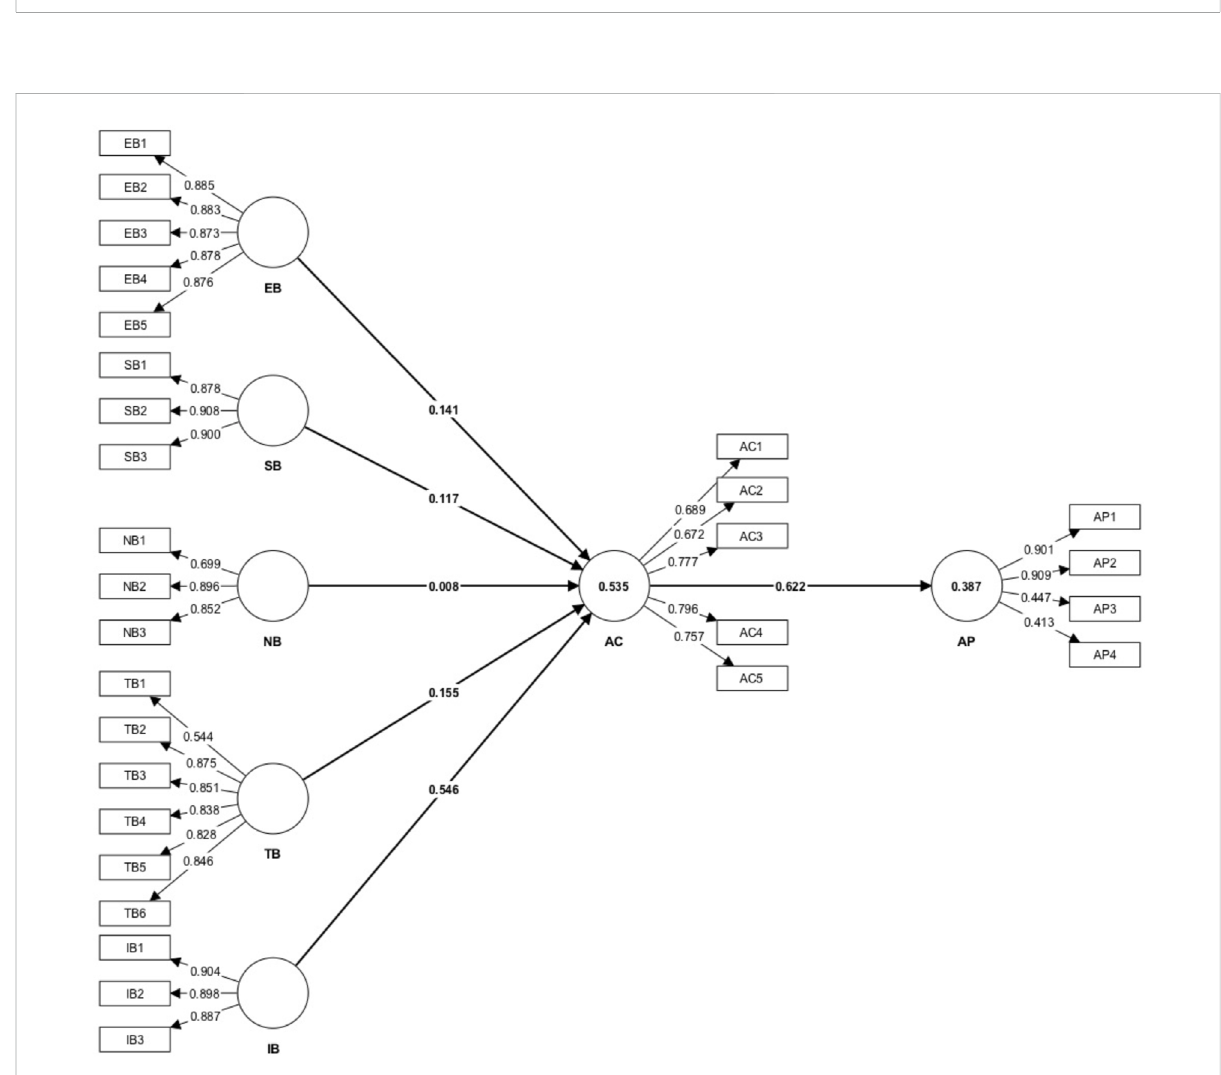
FIGURE 2 Measurement model with outer